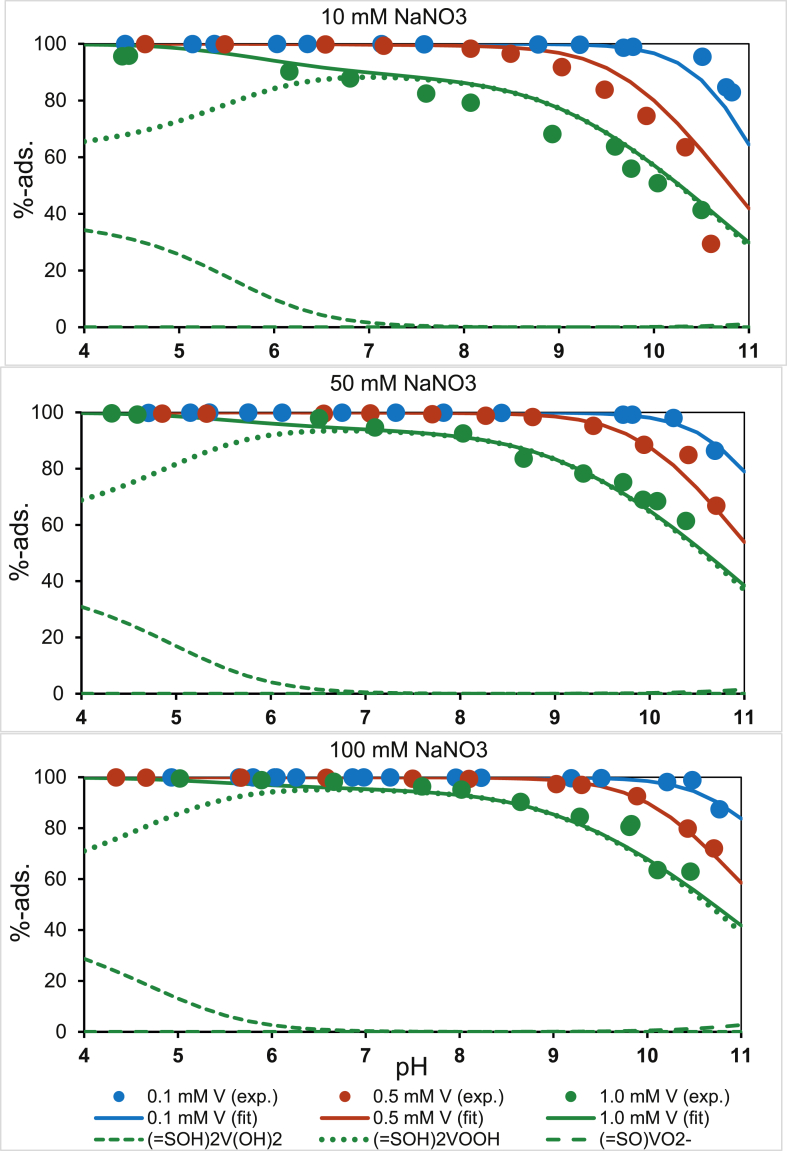
Plots of vanadate adsorption vs. pH for GFH. The dots represent experimental data and the lines show the model fits achieved using the CD-MUSIC parameters suggested by Larsson et al. (2017) and optimized for the GFH.